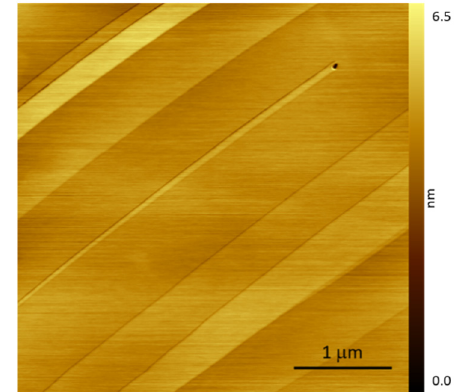
Figure 4. A (4 × 4) μ m 2 atomic force microscopy (AFM) image of a freshly exfoliated graphite substrate. Clear steps and terraces are visible in the image.